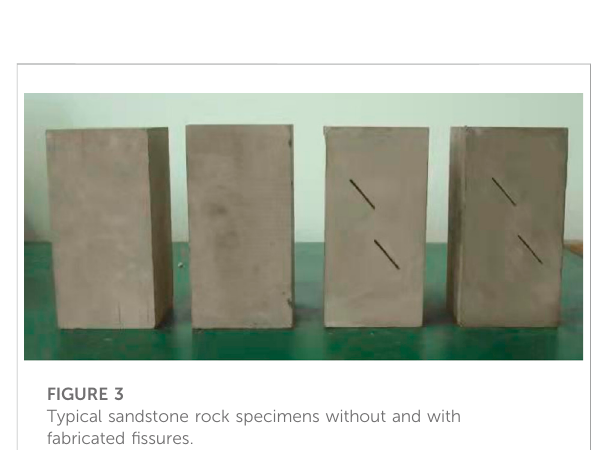
FIGURE 3 Typical sandstone rock specimens without and with fabricated fi ssures.